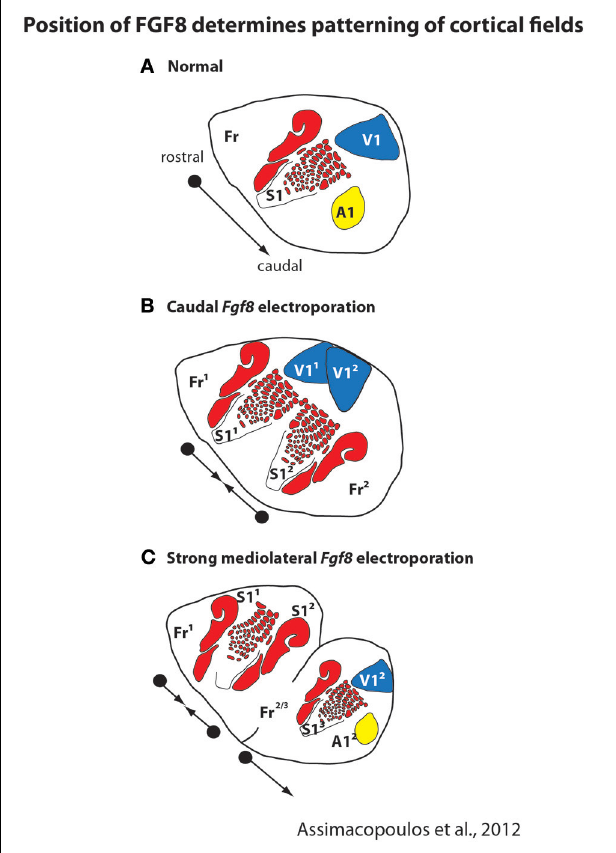
FIGURE 4 | Early in development the position and strength of morphogens, such as FGF8, determines the location and patterning of cortical fields on the cortical sheet. In normal mice (A) , FGF8 is expressed early in development in the rostromedial neocortical primordium and forms a rostro-caudal gradient that regulates subsequent rostrocaudal patterns of gene expression. Studies in which Fgf8 is electroporated at differing levels and in different locations in the embryonic mouse (E10.5) demonstrate its importance as an early cortical map organizer. Ectopic placement can result in the duplication of a cortical field ( B ; S1 1 and S1 2 ) or multiple cortical fields arranged along variant rostro-caudal axes (C) . These new duplicated fields are also functionally distinct and form topographic maps, as in normal animals. Modified from Assimacopoulos et al.